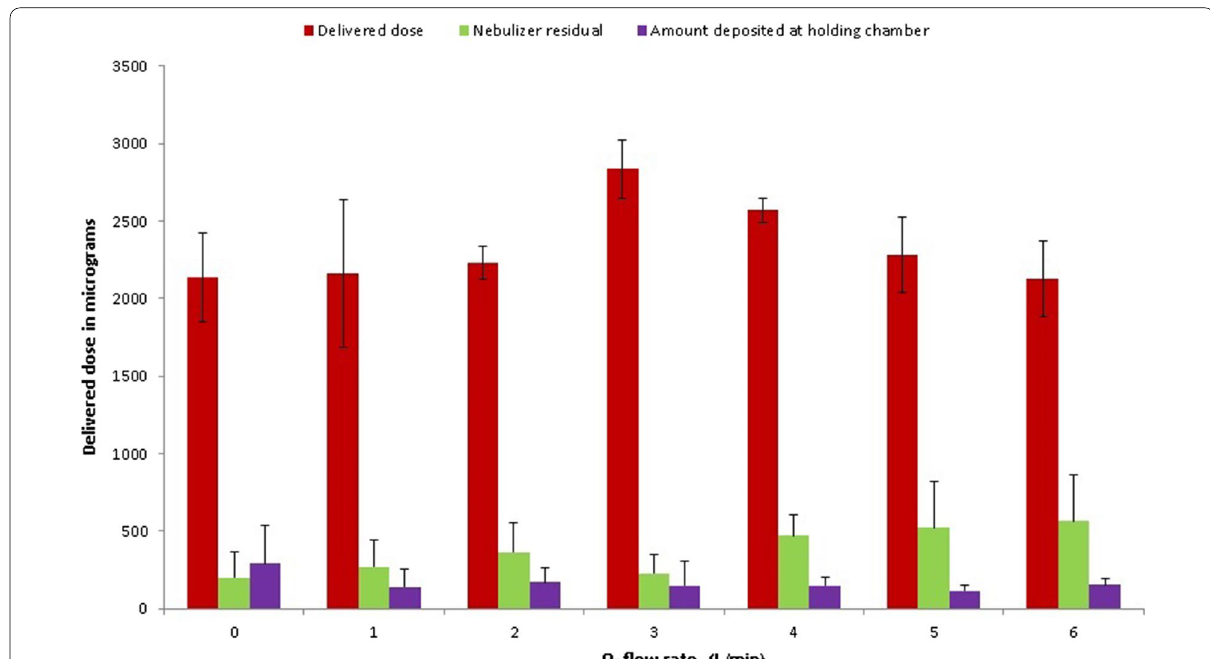
Fig. 3 Fate of supplied doses of salbutamol (the inhalation filter, nebulizer residual, and amount deposited in holding chamber in micrograms at different oxygen flows using a valved